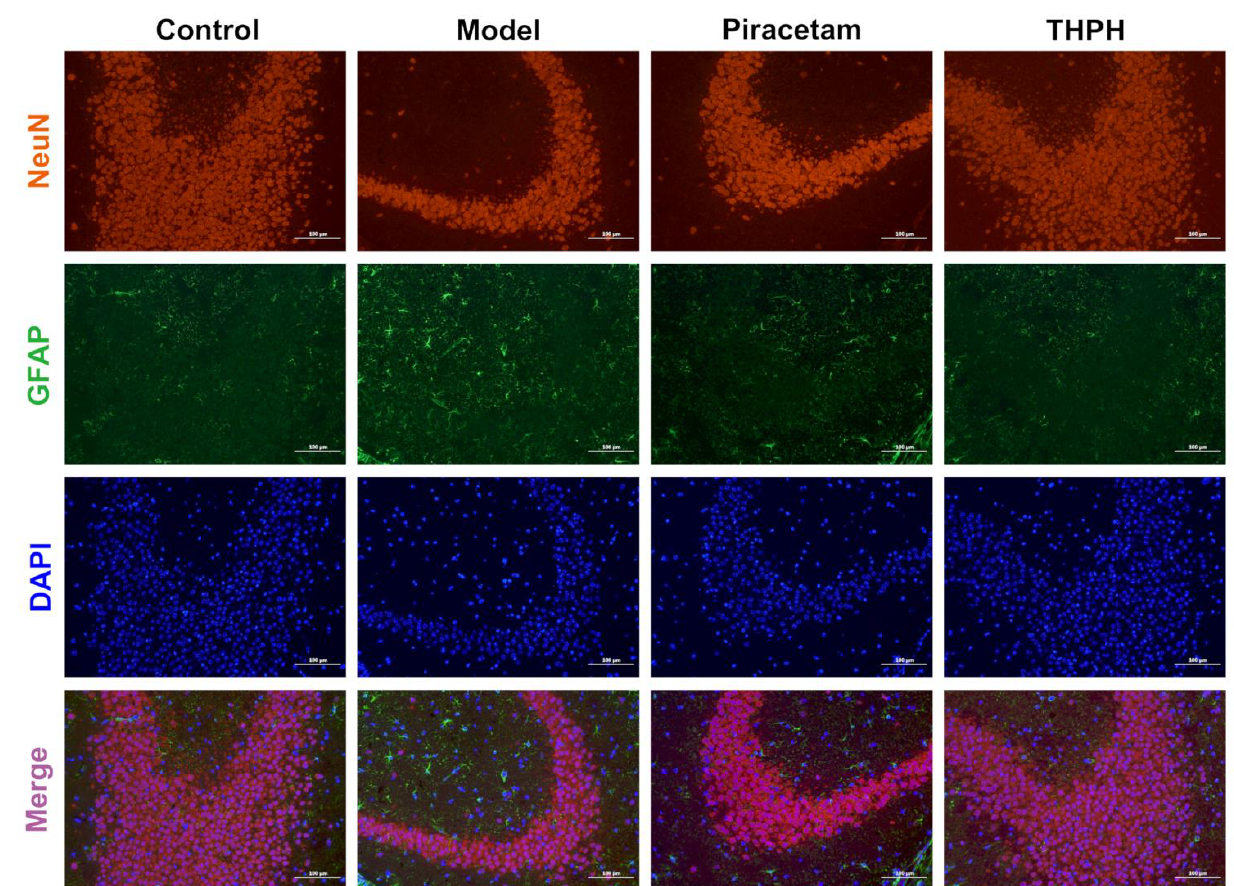
Figure 4. The neuroprotective effects of THPH on increasing the number of mature neurons and modulating activated astrocyte clusters in the hippocampal CA3 region of scopolamine-induced amnesia mice. Immunostaining for NeuN (red) to mark mature neurons, GFAP (green) to mark activated astrocytes in the hippocampal CA3 region of each group, and DAPI (blue) to mark the nucleus of living cells, Merge (purple) represents the superposition of the above fluorescence, scale bar is 100 μm.